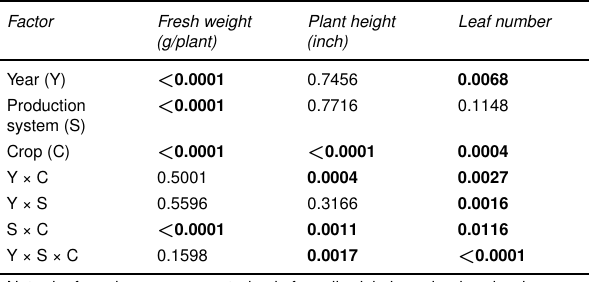
Table 1. P-values of the three-way ANOVA tests for the main and interactive effects of the year (2018 and 2020), production system (organic and conventional) and crop (col- lard, kale, lettuce, swiss chard) on fresh weight, plant height and leaf number. Significant treatment effects at P ≤ 0.05